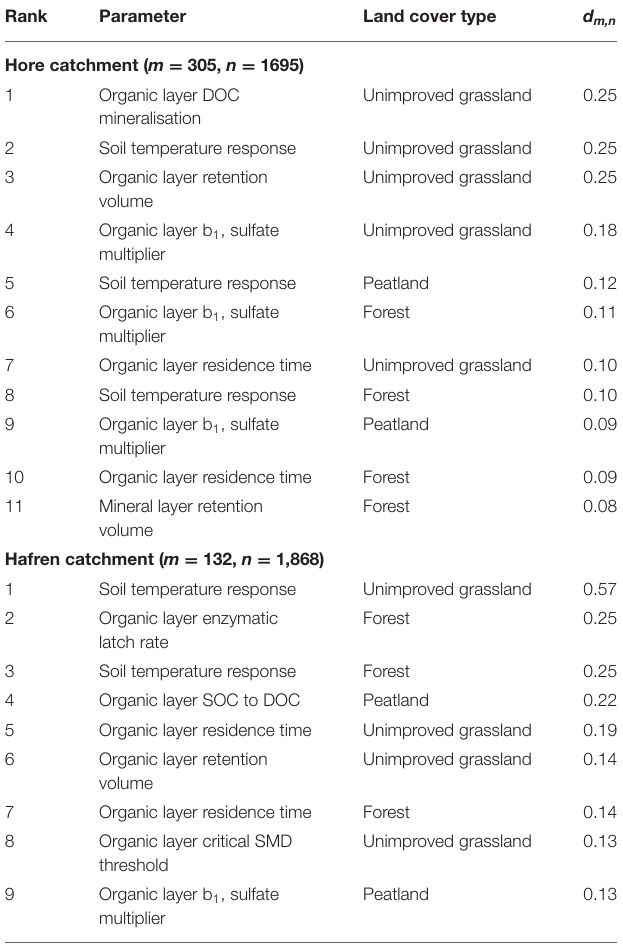
TABLE 4 | Kolmogorov-Smirnov Statistics (significant at 95% level or greater) in the GSA of parameters influencing model